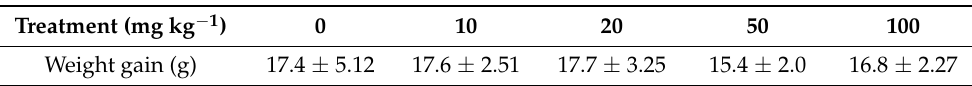
Table 2. The effects of different concentrations of 2,6-DCBQ on weight gain of mice after 30 d of exposure.